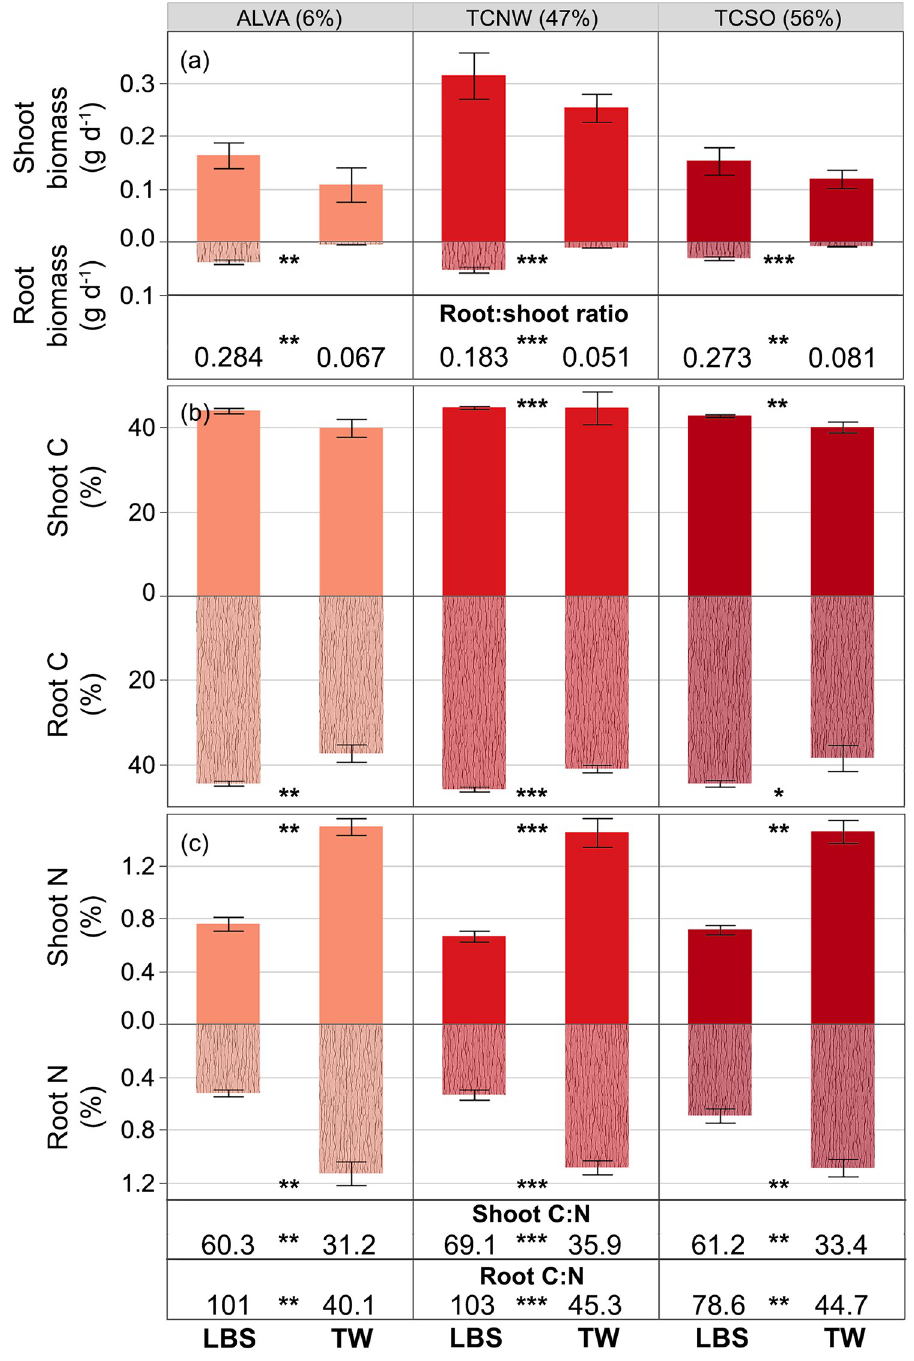
Fig 3. Little bluestem (LBS) and Texas wintergrass (TW) plant traits. Differences in (a) mean ( ± 1SE) biomass accumulation, allocation, (b) tissue C, and (c) tissue N between native prairie grass species at three sites characterized by low (pink) to high (crimson red) urban development in the Dallas-Fort Worth metropolitan area. � p < 0.1, �� p < 0.05, ��� p <